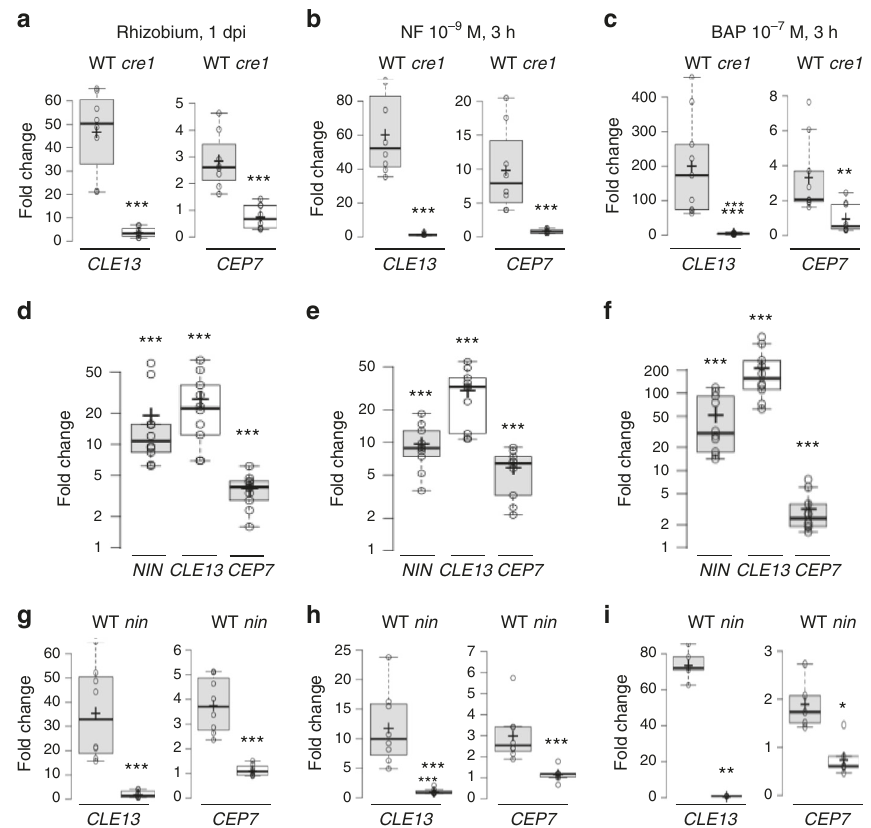
Fig. 2 Rhizobia, Nod factor, and cytokinin regulation of CEP7 and CLE13 expression relies on the CRE1 cytokinin receptor and on the NIN transcription factor. a – c Expression analysis of the MtCEP7 and MtCLE13 genes in wild-type (WT) or cre1 mutant roots in response to a 1 day post rhizobial inoculation (1 dpi) ( a ), to a Nod factor (NF) 10 − 9 M treatment for 3 h ( b ), or to a cytokinin (BAP 10 − 7 M) treatment for 3 h ( c ). qRT-PCR was used to measure the gene expression levels in treated roots, normalized relative to untreated roots. Data points from four biological replicates are plotted as open circles ( n ≥ 8). d – f Expression analysis of MtNIN , MtCLE13 , and MtCEP7 genes in WT roots in response to a rhizobial inoculation 1 dpi ( d ), to an NF 10 − 9 M treatment for 3 h ( e ), or to a cytokinin (BAP 10 − 7 M) treatment for 3 h ( f ). qRT-PCR was used to measure the gene expression levels in treated roots, normalized relative to untreated roots. Data points from fi ve biological replicates are plotted as open circles ( n ≥ 10). g – i Expression analysis of MtCLE13 and MtCEP7 genes in WT and nin mutant roots in response to a rhizobial inoculation 1 dpi ( g ), to an NF 10 − 9 M treatment for 3 h ( h ), or to a cytokinin (BAP 10 − 7 M) treatment for 3 h ( i ). qRT-PCR was used to measure the gene expression levels in treated roots, normalized relative to untreated roots. Data points from at least three biological replicates are plotted as open circles ( n = 8 except i , n ≥ 5). In a – i , center lines show the medians; box limits indicate the 25th and 75th percentiles as determined by the R software; whiskers extend 1.5 times the interquartile range from the 25th and 75th percentiles, outliers are represented by dots; and crosses represent sample means. Mann – Whitney test was used for each gene to assess signi fi cant differences between treatments in the WT and in the mutant (in a – c and g – i ) or between treated and control conditions (in d – f ), as indicated by asterisks (* α < 0.05; ** α < 0.01; *** α < We thus performed chromatin immunoprecipitation (ChIP) in rhizobia-inoculated roots of WT plants and nin mutants, with a native antibody targeting MtNIN previously validated in Vernié et al. 47 , or with immunoglobulin G (IgG) used as a negative control to evaluate non-speci fi c binding. The IP enrichment of each promoter was measured by quantitative PCR (qPCR) using primers designed in the proximal regions of the MtCLE13 and MtCEP7 promoters that contained the predicted NBS cis -element identi fi ed, or in distal regions (Fig. 4b). An enrichment of the proximal region of the MtCLE13 promoter was detected in the MtNIN IP, compared to the more distal region (Fig. 4c, left panel). This enrichment was not detected for MtNIN IPs per-